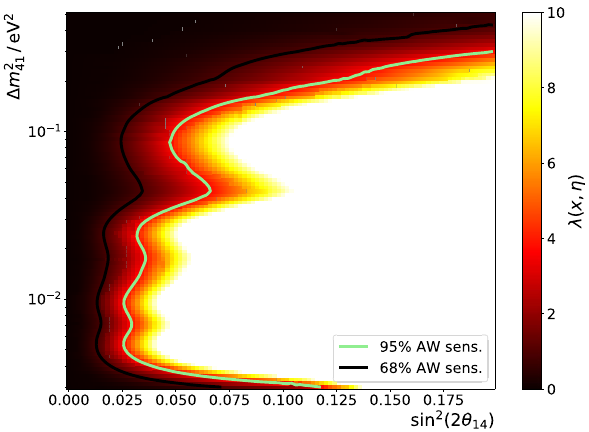
Fig. 4 Teststatistic λ( x , η ) foranAsimovdataset x ofthenullhypoth- esis for a scan of the signal parameter space. All values of sin 2 2 θ 14 = 0 represent the null hypothesis of no-sterile oscillations and correspond- ingly λ = 0 for the Asimov data set. The color scale is clipped at λ = 10. The lines represent the 68% and 95% sensitivity (see text) for constraining sin 2 2 θ 14 as a function of Δ m 2 41 ∂ 2 L ( x | η ) (cid:12)|| should form a positively the parameters ||(cid:11) ∂η ∂η i j